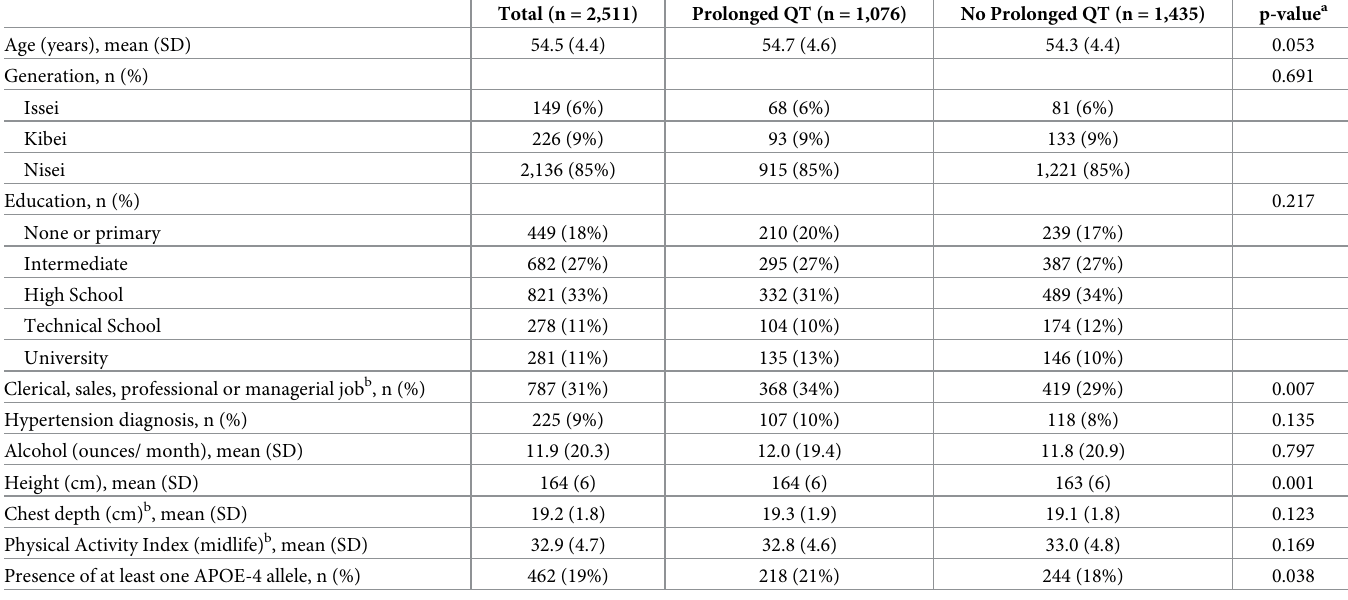
Table 1. Participant characteristics at Exam 2, stratified by incident prolonged QT interval at midlife (Exam 2 or